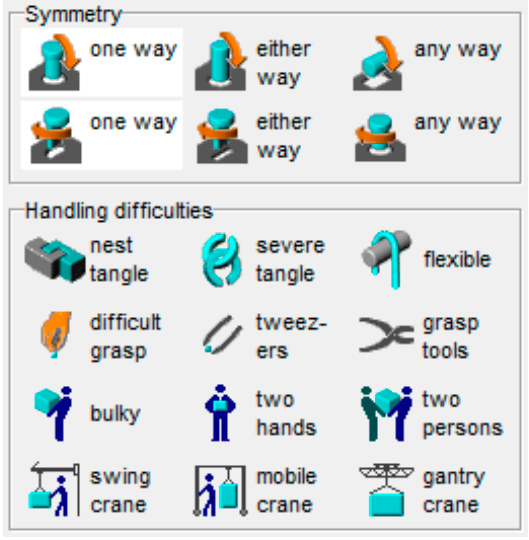
Figure 6. Selection of symmetry for diagram for side mounting top bracket.